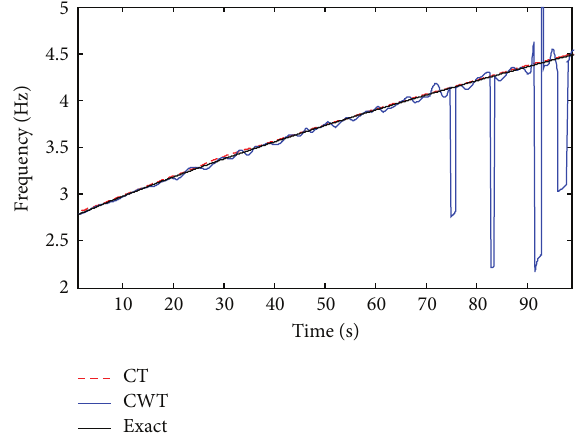
Figure 9: Identification results of case